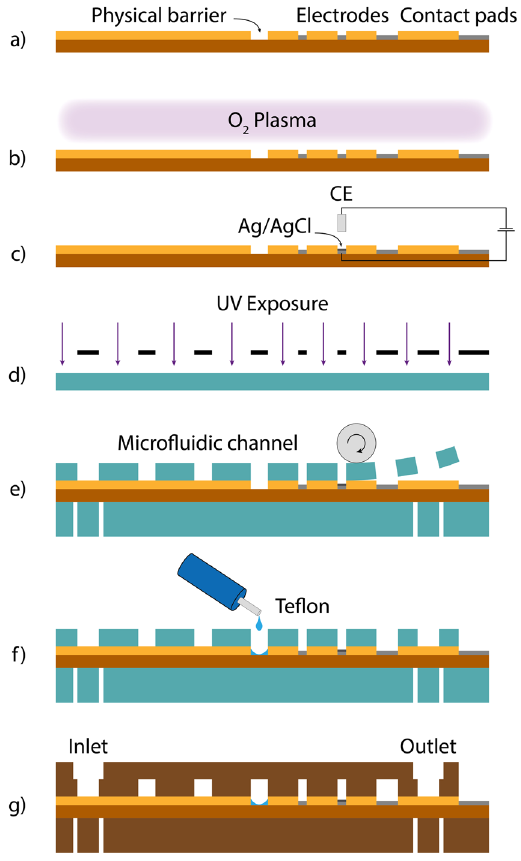
Figure 5. Illustration of the different fabrication steps of the microfluidic biosensor platform: ( a ) a Pt structured polyimide substrate isolated with SU-8 ( b ) O 2 Plasma process to remove SU-8 residues on the Pt electrodes ( c ) galvanic deposition of the Ag/AgCl reference electrode ( d ) exposure of different DFR layers ( e ) lamination of the DFR layers onto the substrate ( f ) Applying Teflon ® to embed the stopping barrier ( g ) final electrochemical microfluidic